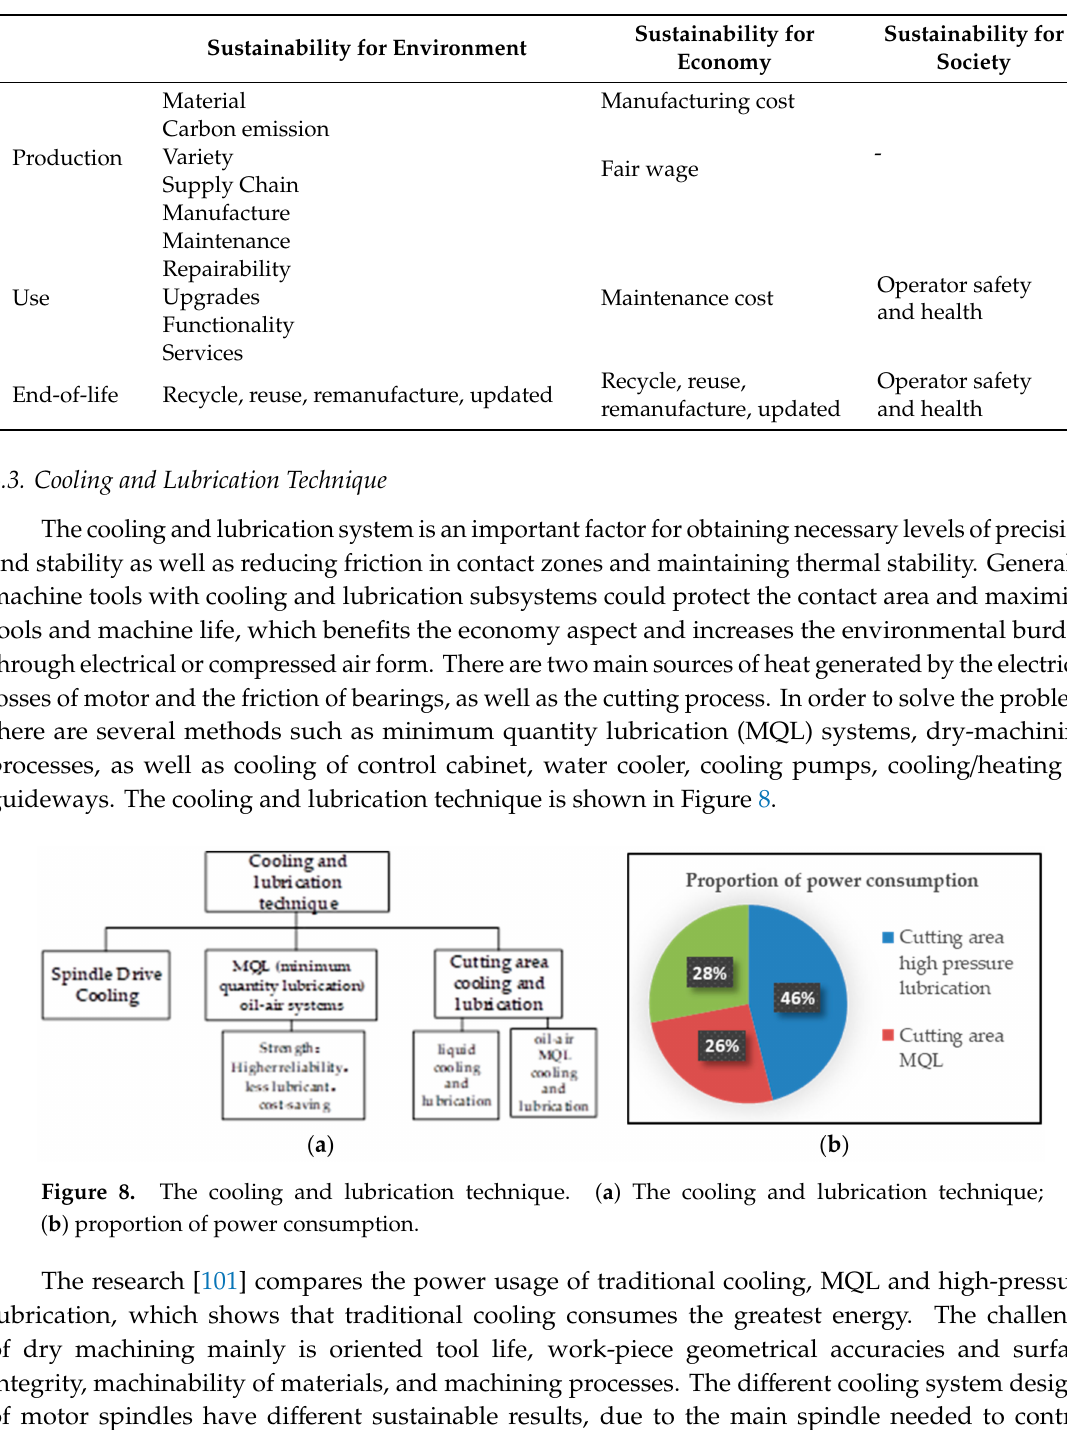
Table 4. Sustainability benefits for modular machine tool in each life cycle phase [99,100].